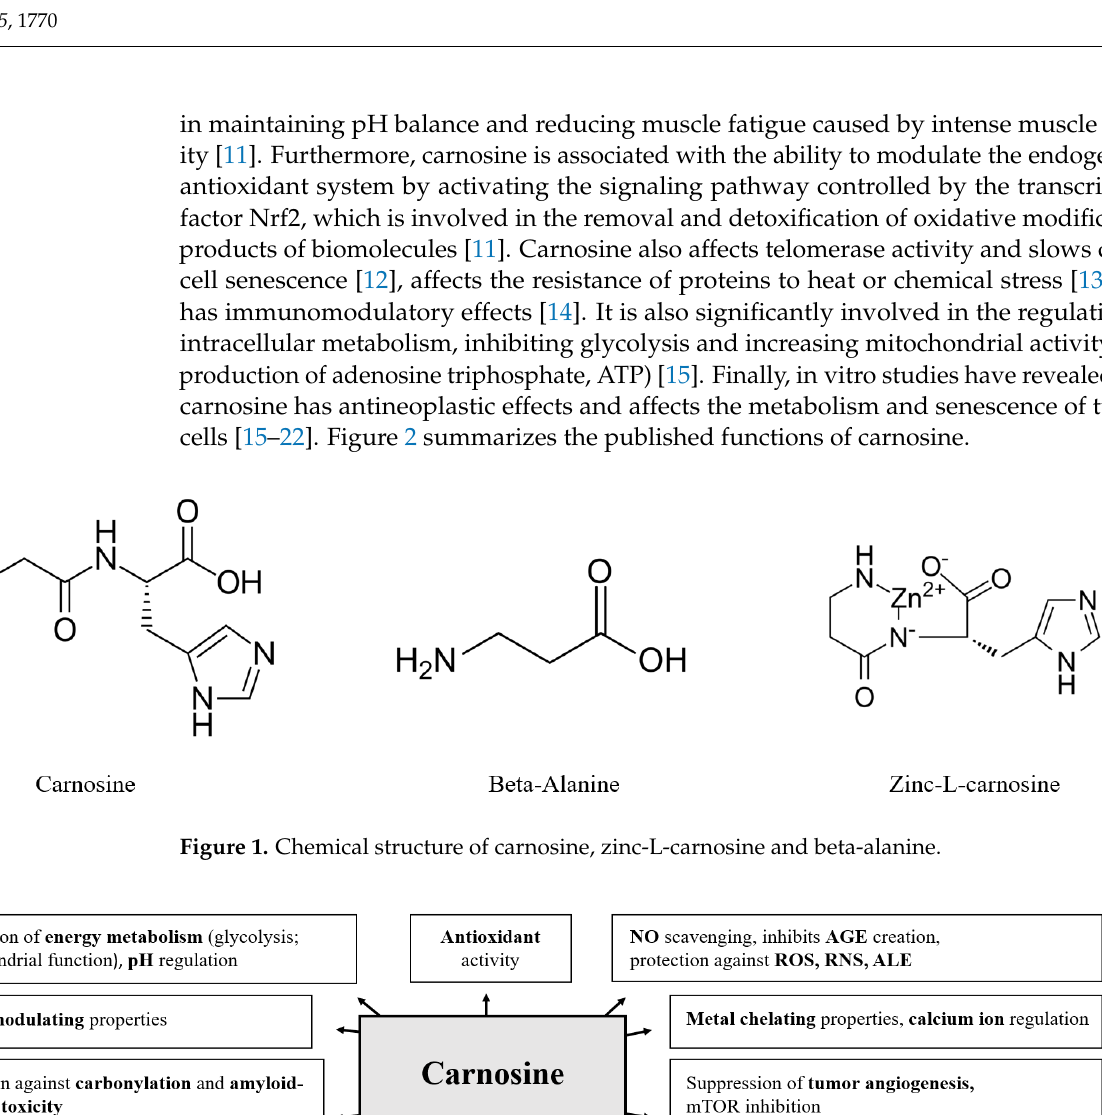
Figure 1. Chemical structure of carnosine, zinc-L-carnosine and beta-alanine.